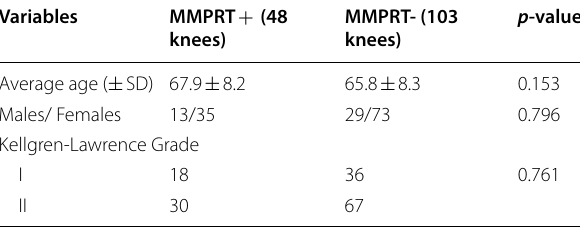
MMPRT: medial meniscus posterior root tear, ns non-significant The p -value determined by Student’s t test was presented up to three decimal places